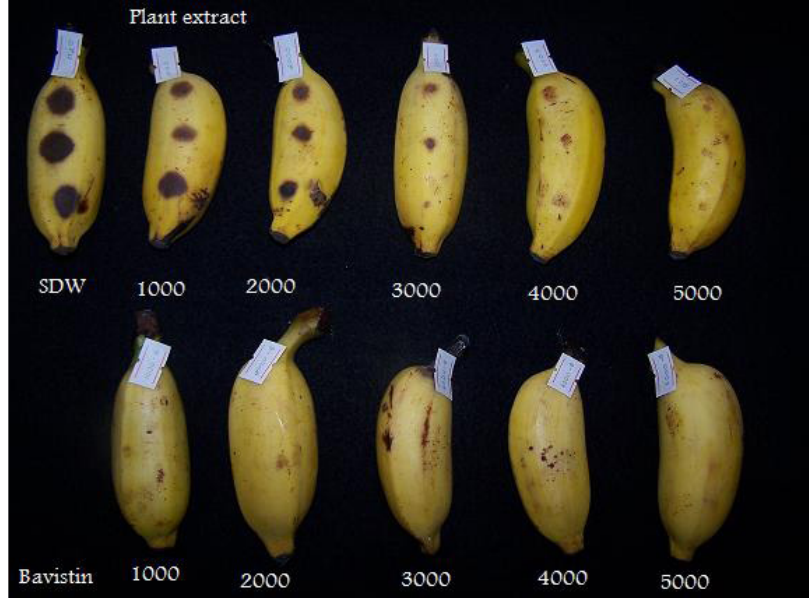
Figure 3: Anthracnose development in